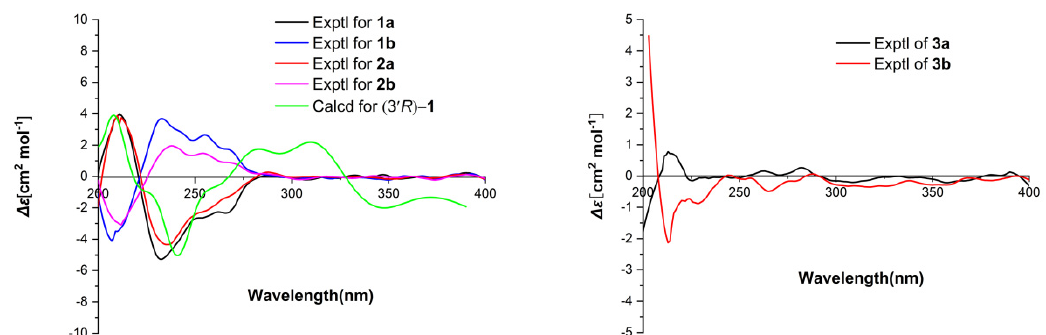
Figure 3. Comparison of the calculated ECD spectrum for (3 ʹ R ) - 1 at B3LYP/6-311g(d,p) level with the experimental spectra of 1a , 1 b , 2a , 2 b in MeOH (left), σ = 0.2 eV, shift = − 10 nm. The experimental spectra of 3a ,3 b in MeOH (right).